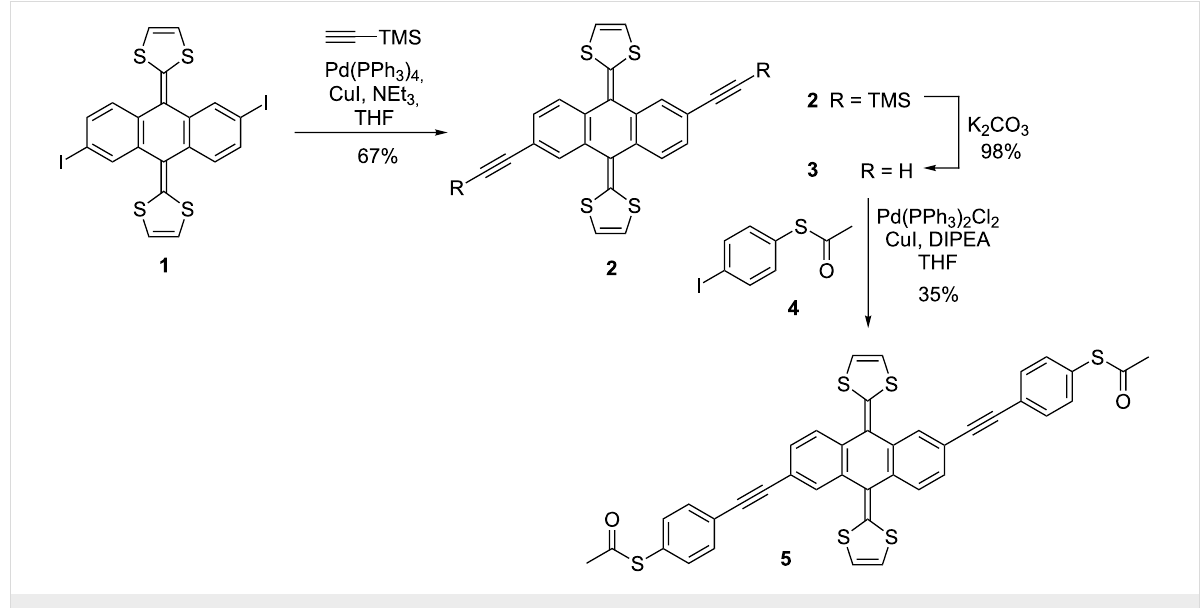
Scheme 1: Synthetic route to the target exTTF-based molecular wire 5 .